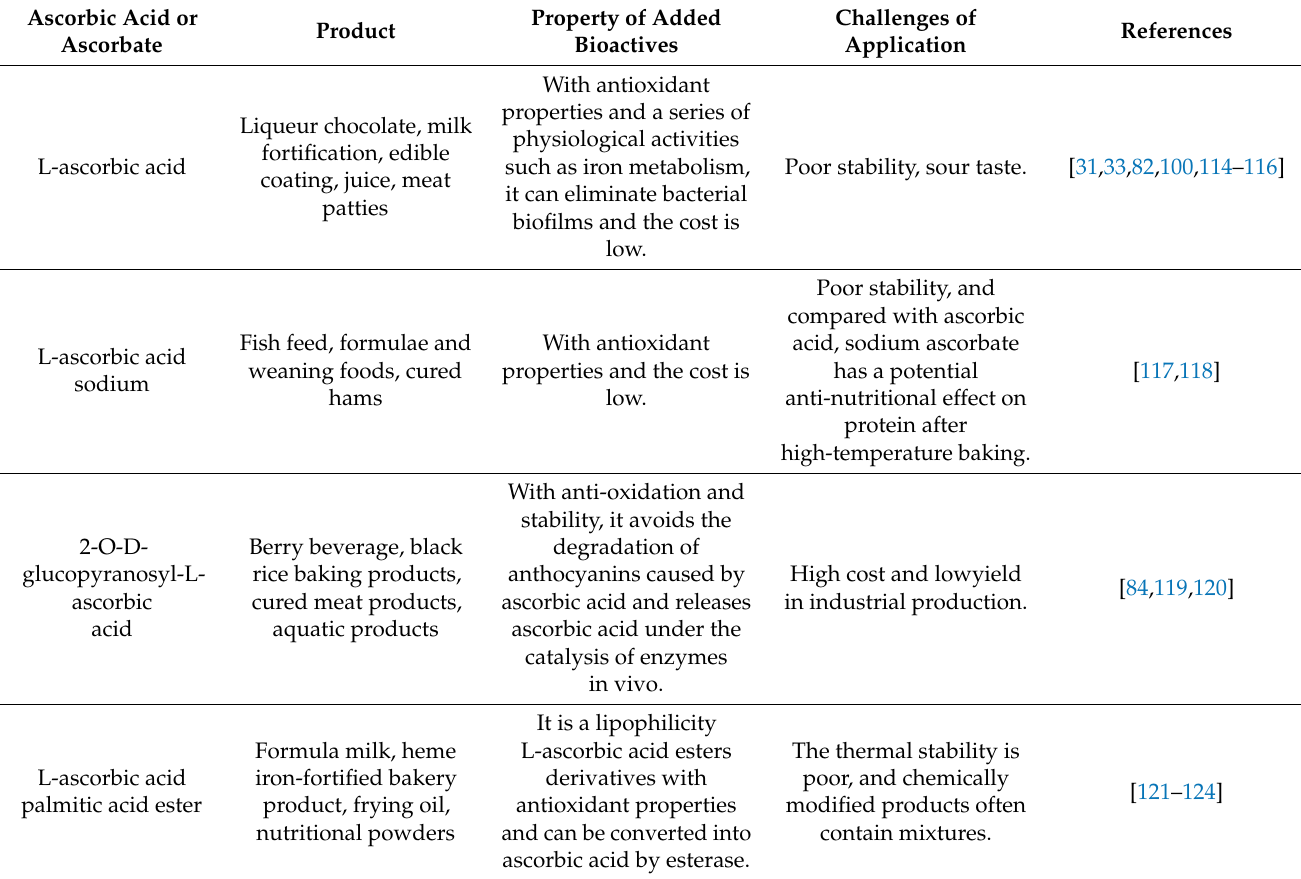
Table 2. Commercial products fortified with ascorbic acid and its